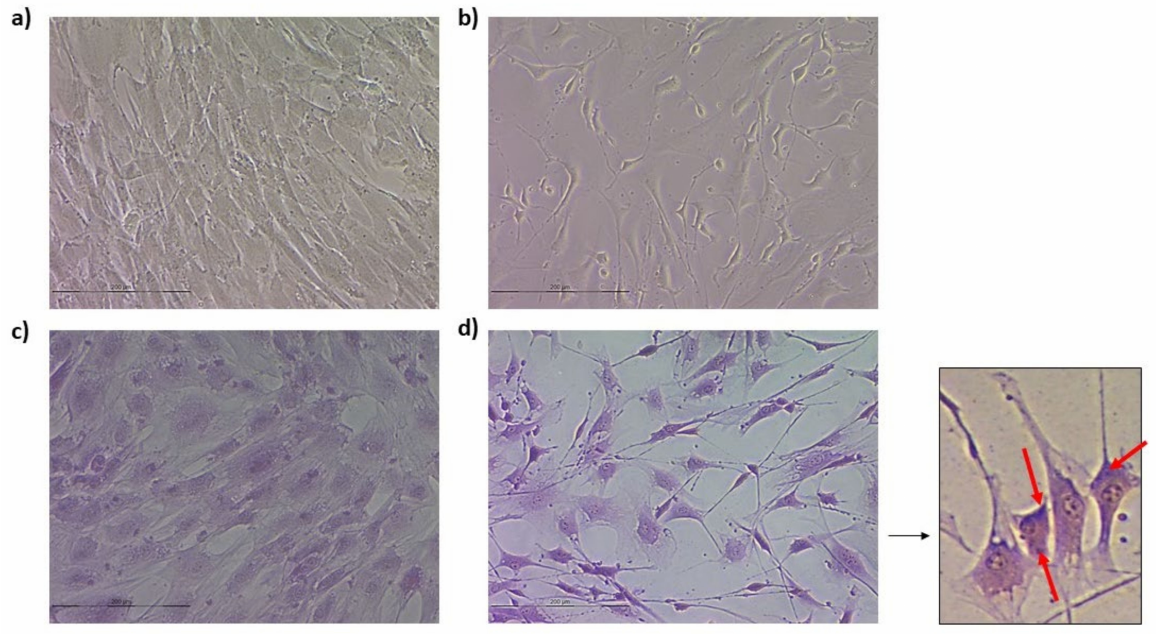
Figure 4. oBM-MSCs in basal ( a ) and neurogenic differentiation ( b ) conditions. Cresyl Violet staining of oBM-MSCs in basal medium ( c ) and oBM-MSC derived neuron-like cells ( d ) 3 days after neurogenic induction. Nissl bodies present in neuron-like cells are marked with red arrows. Table 1. Expression levels of neuronal markers NEFM , MAP2, and TUBB3 in oBM-MSCs and